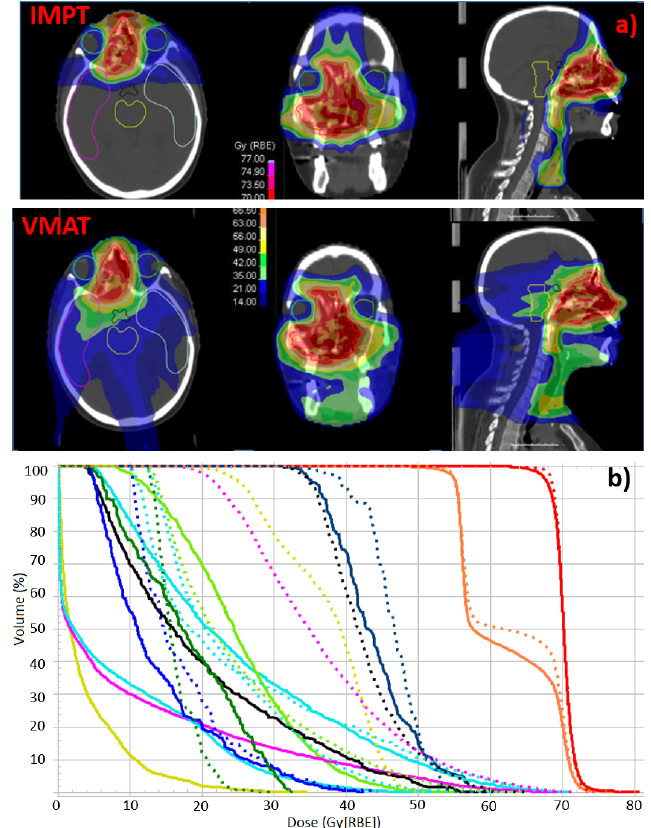
Figure 1. ( a ) Representative example of dose distribution for IMPT and VMAT plans. ( b ) DVH for the selected patient case and OARs; solid and dashed lines refer to IMPT and VMAT plans respectively